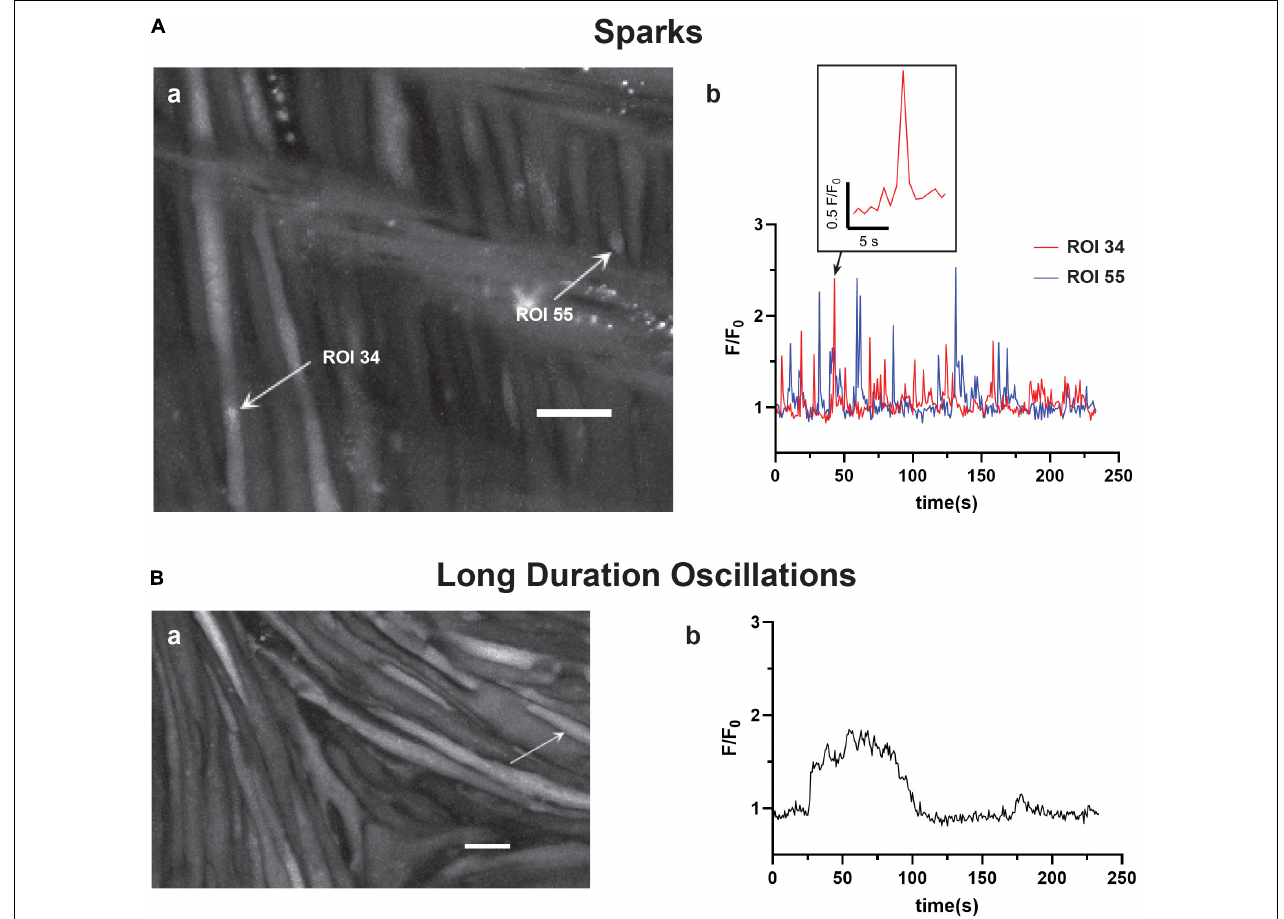
FIGURE 2 | Basilar arterial myocytes show additional distinct forms of Ca 2 + signals. The figure shows (a) maximum intensity projections with arrows pointing to regions of interest that correspond to the fluorescence intensity tracings shown in (b). This includes (A) short duration Ca 2 + “spark” events (0–4 s) and (B) long duration Ca 2 + oscillations (40+s). The labeled time-series tracings of F/F 0 for these two types of Ca 2 + responses were recorded using Fluo-4 and then detected and evaluated post hoc with LCPro. Scale bars (white) in (Aa and Ba) = 10 µ